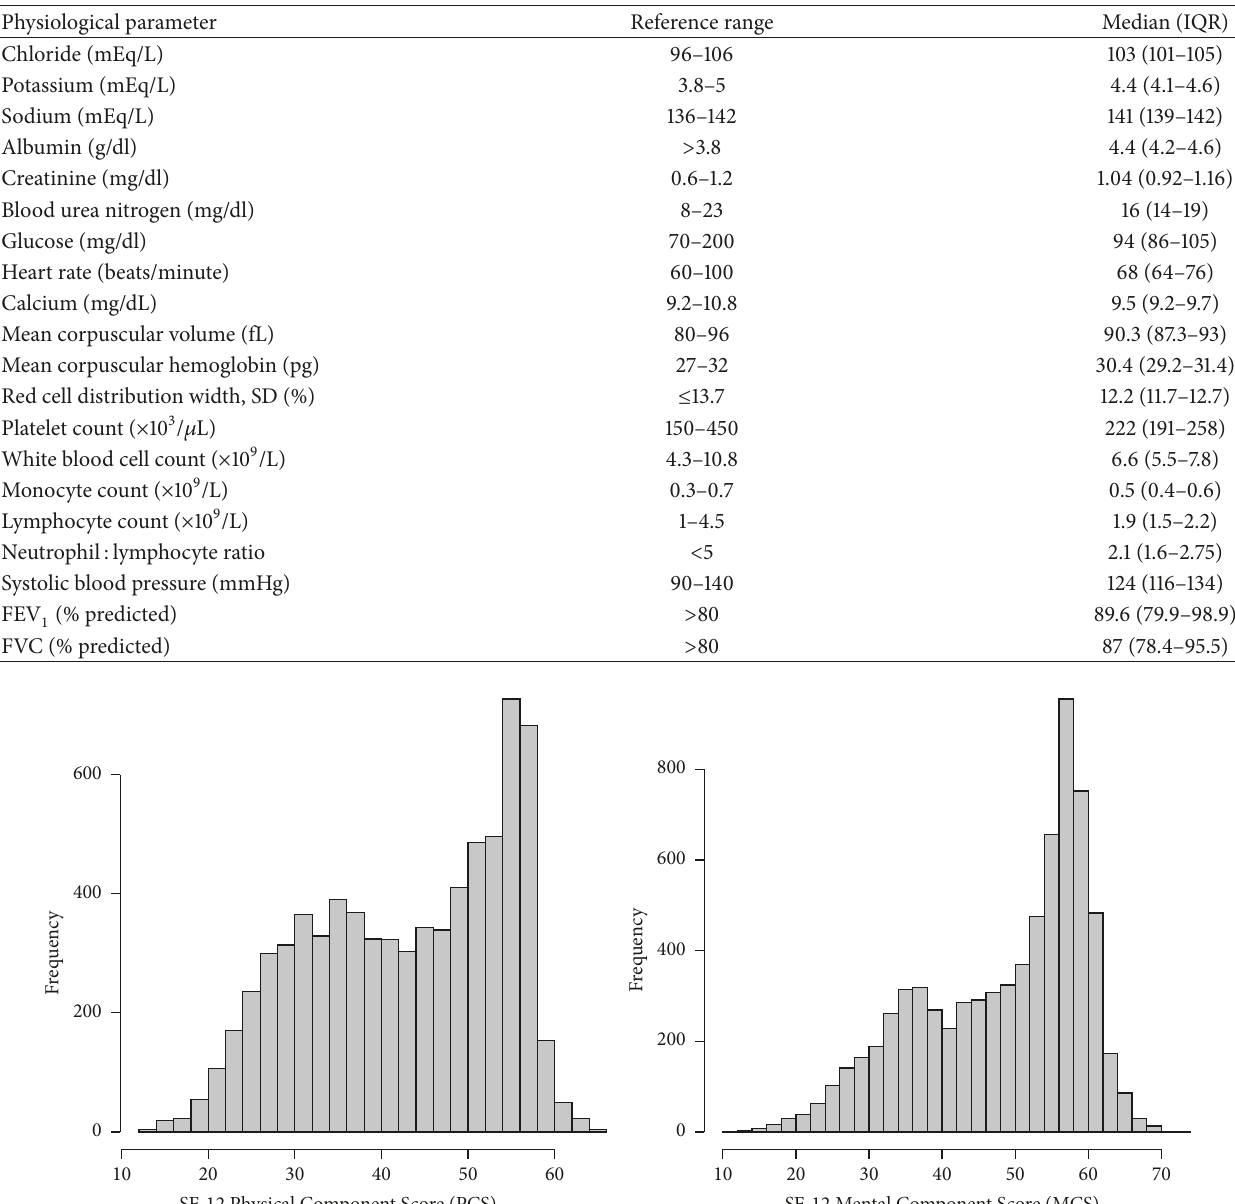
Table 3: Median (IQR) measured at index visit for study sample (𝑛 = 7 , 346) .